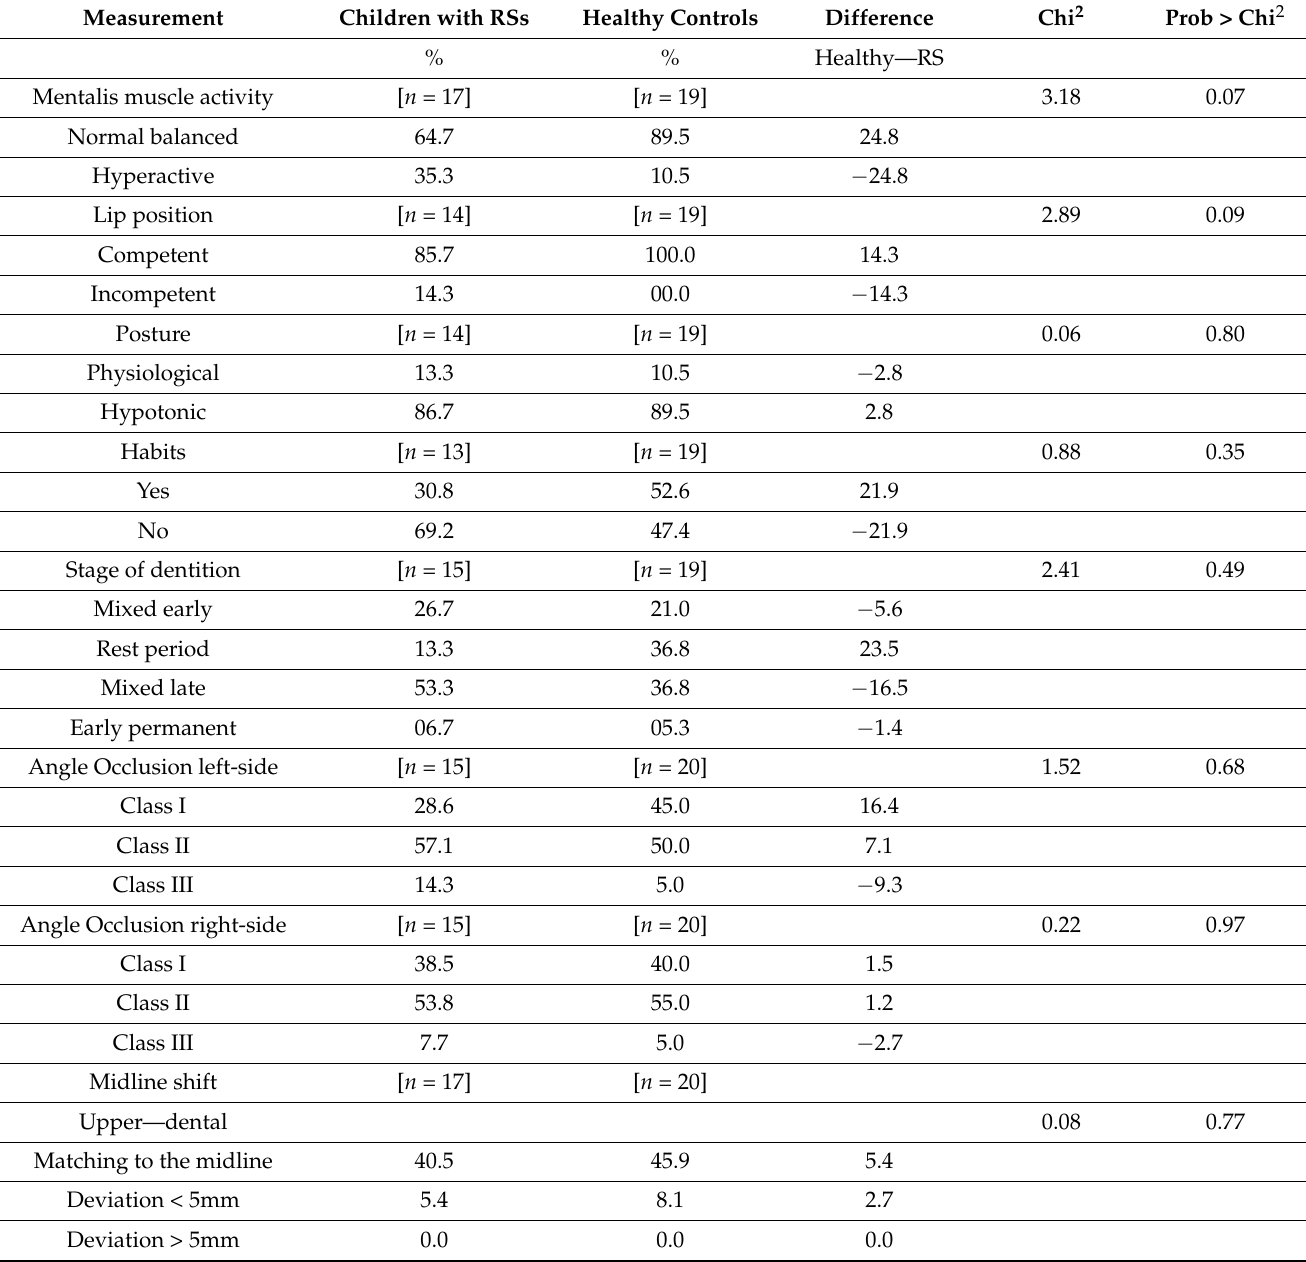
Table 2. Orthodontic evaluation: children with RS versus healthy control